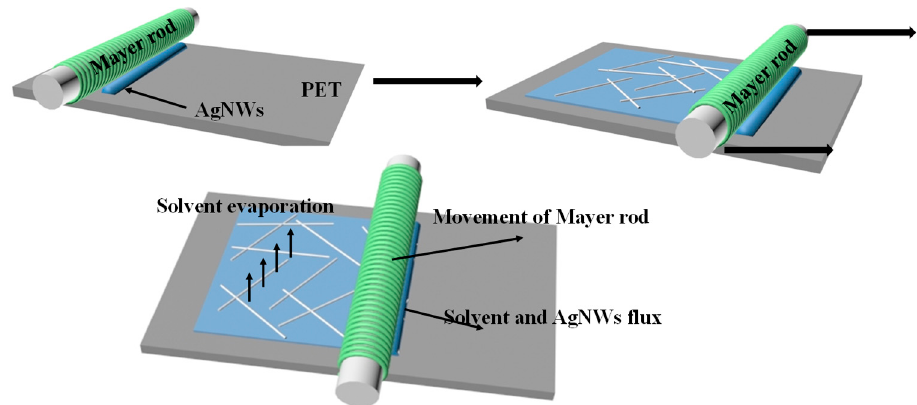
Figure 4. Schematic diagram illustrating the fabrication of an AgNW-flexible transparent conducting films (FTCF) using the Mayer rod method .